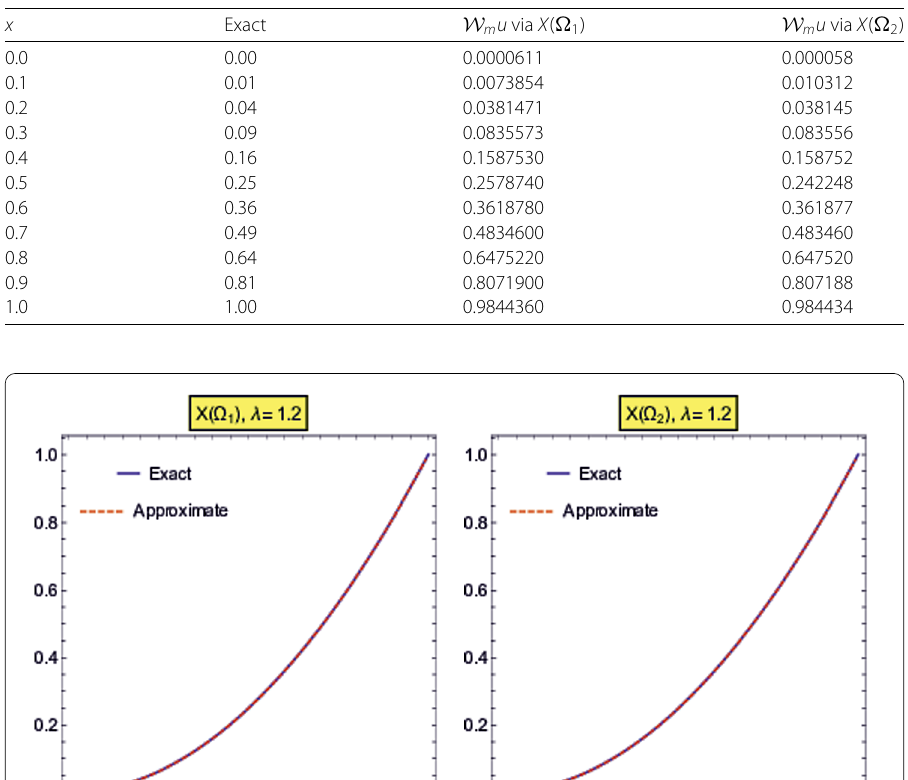
Table 4 Numerical results of Example 4.4 using the framelet systems X ( (cid:7) 1 ) and X ( (cid:7) 2 ) for m = 3 and λ = 6/5